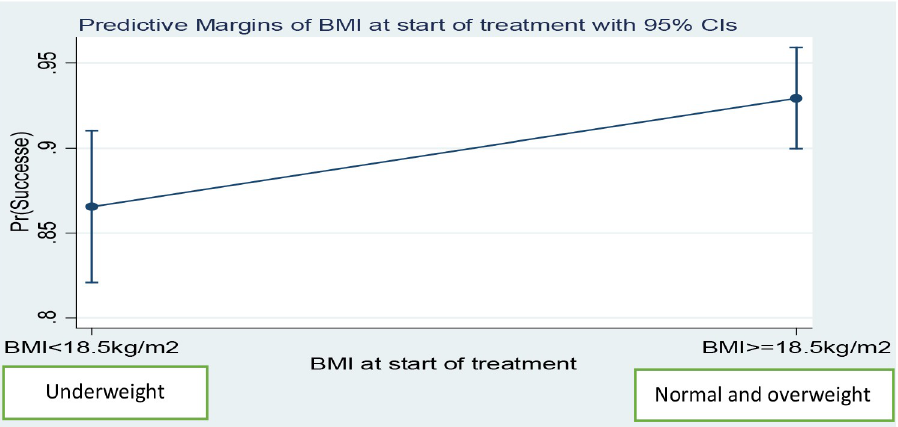
Fig 2. Predicted probability of treatment successes by BMI at the start of treatment among adult TB patients in public health centers of Addis Ababa, Ethiopia, 2019.